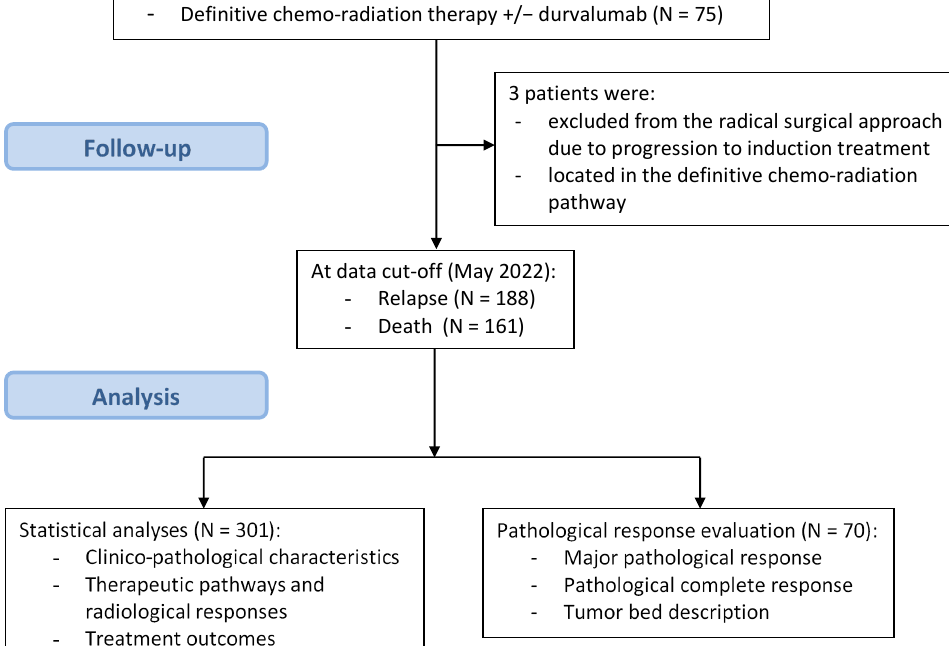
Figure 1. Consort flow diagram.